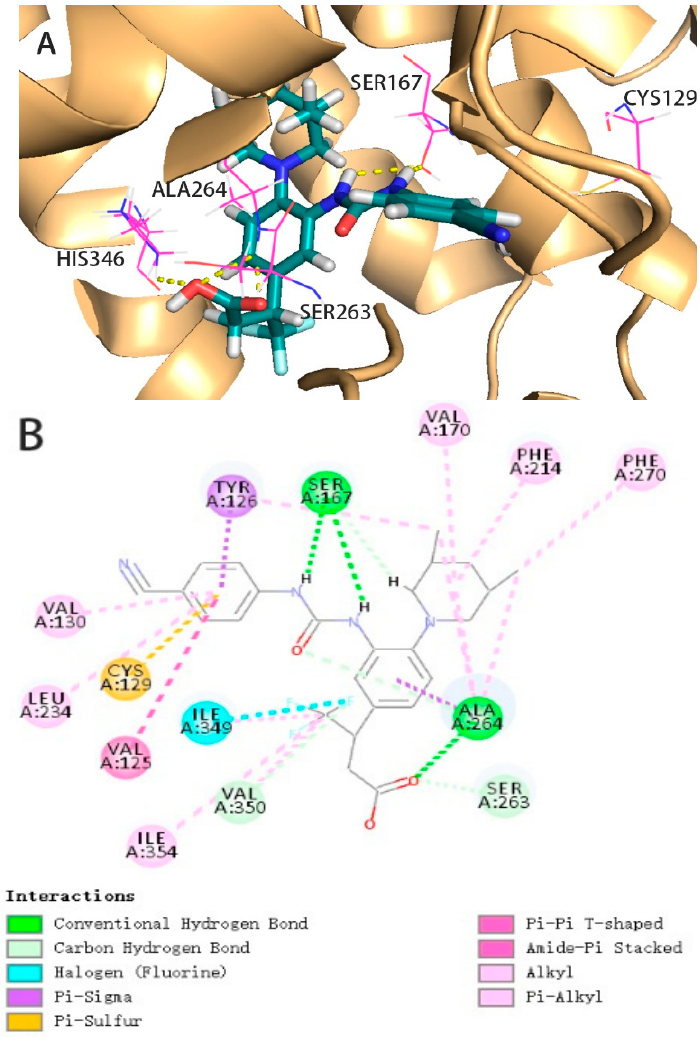
Figure 2. Predicated binding mode of compound i12 with IDO1 using CDOCKER. ( A ) The binding mode of compound i12 with IDO1 (6AZV), the enzyme is shown in yellowish brown, compound i12 is shown as sticks with cyan carbon atoms. The residues that interact with compound i12 are shown as sticks with pink carbon atoms, and hydrogen bonds are indicated by yellow dashed lines. The images were generated by using Chimera 1.12. ( B ) Schematic 2D diagram of the key interactions between compound i12 with IDO1 (6AZV).